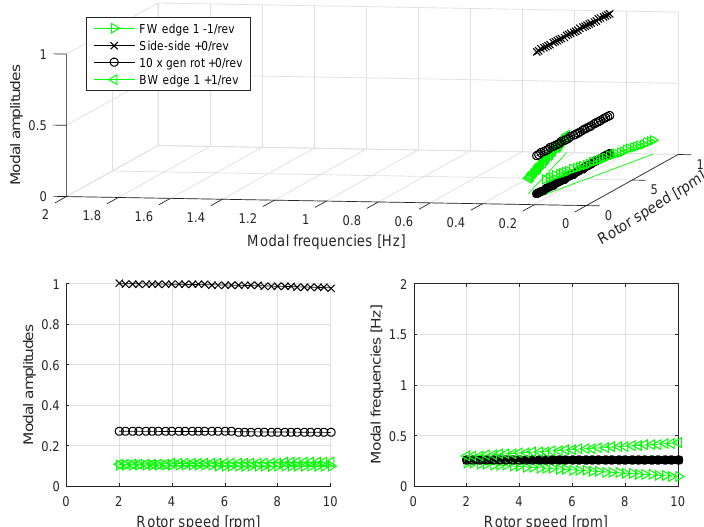
Figure 6. Harmonic modal components for the three-bladed turbine mode dominated by tower side–side motion. Plot layout as in Fig. 5.